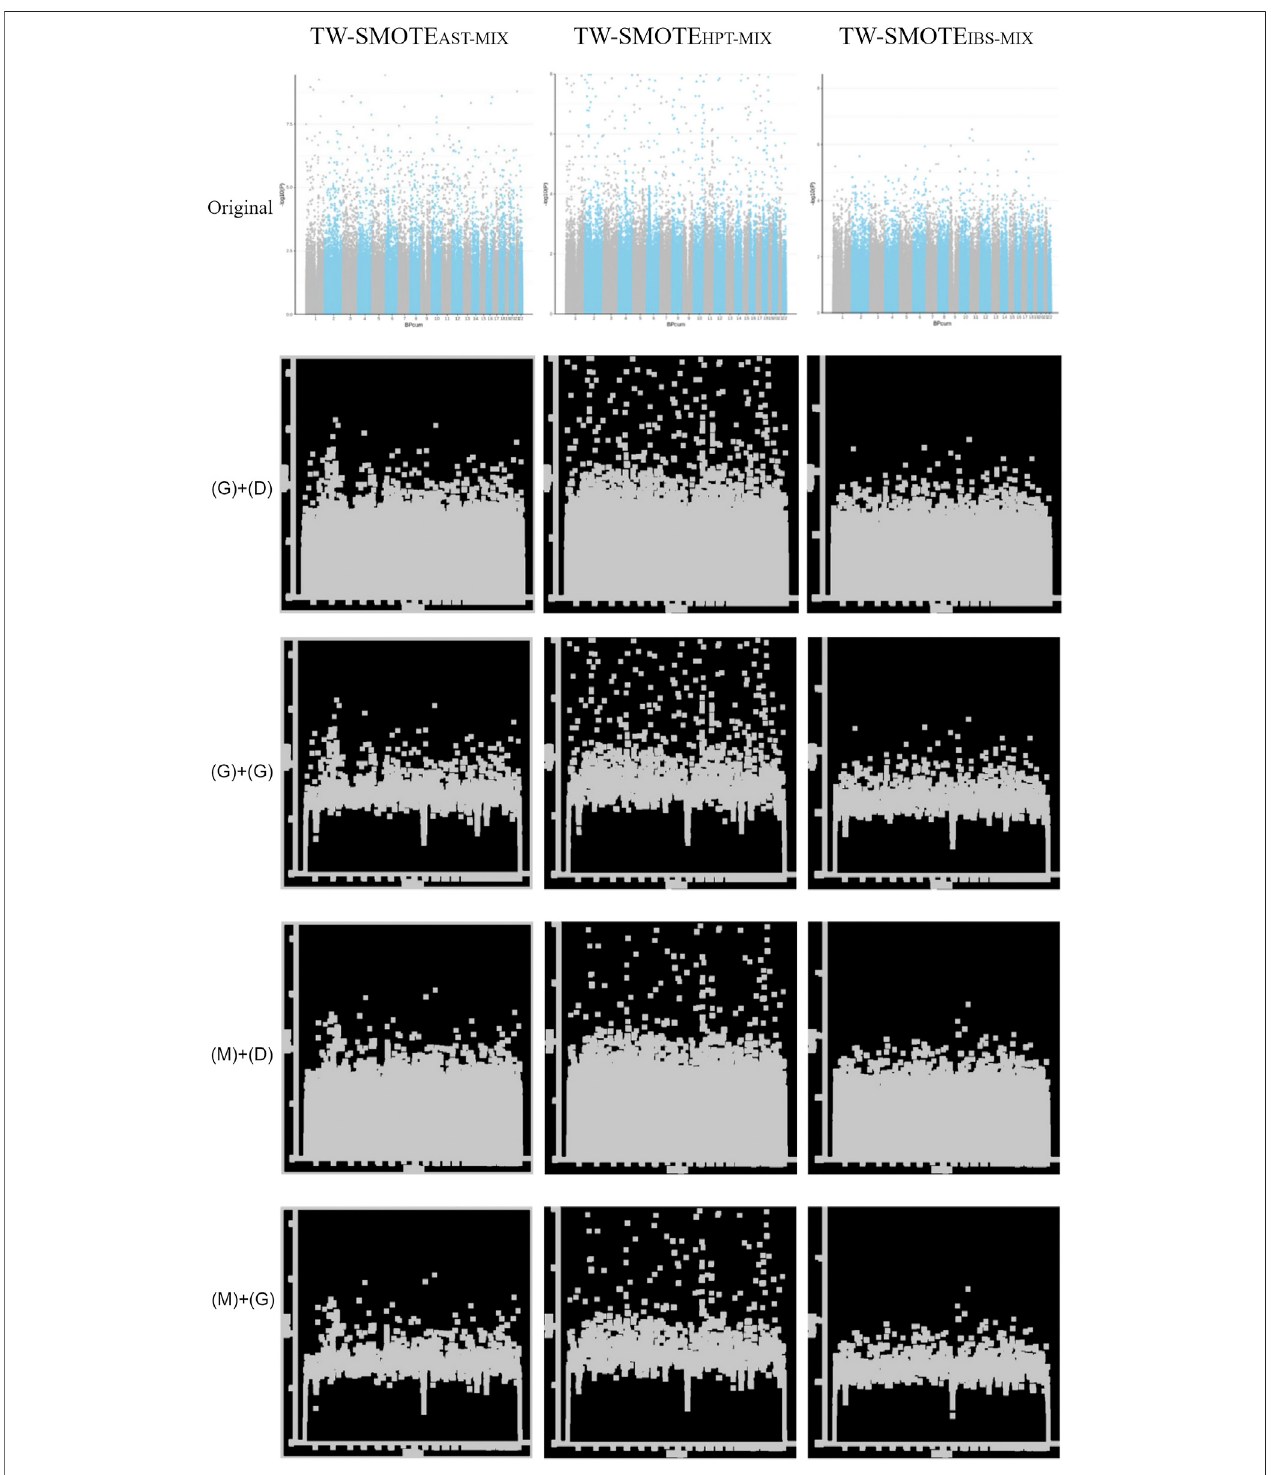
FIGURE2| ParametersformodifyingtheSMOTEadjustmentratiosweredeterminedusingamixturesettingwithTW-SMOTE AST-MIX ,TW-SMOTE HPT-MIX ,andTW- SMOTE IBS-MIX (AST=0.001,HPT=0.005,andIBS=0.03)in “ original ” labeled,Gaussian fi lter(G)+dilation(D),Gaussian fi lter(G)+morphologicalgradientoperation(G), median fi lter (M) + dilation (D), and median fi lter (M) + morphological gradient operation (G).